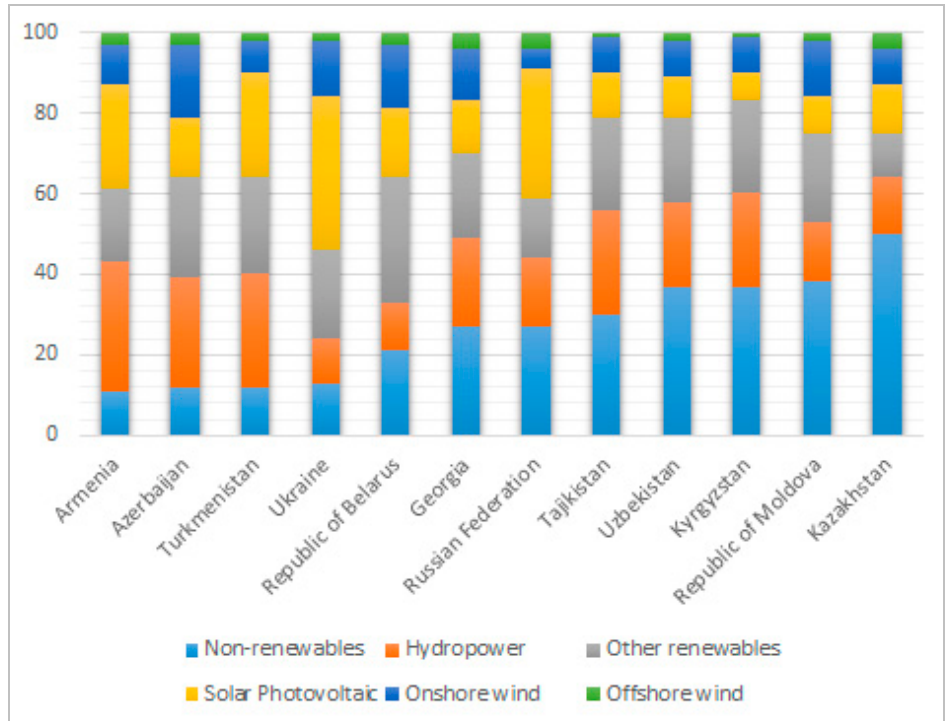
Figure 3. Share of RES in power generation in EECCA countries according to TES in 2050. Source: compiled by the authors.